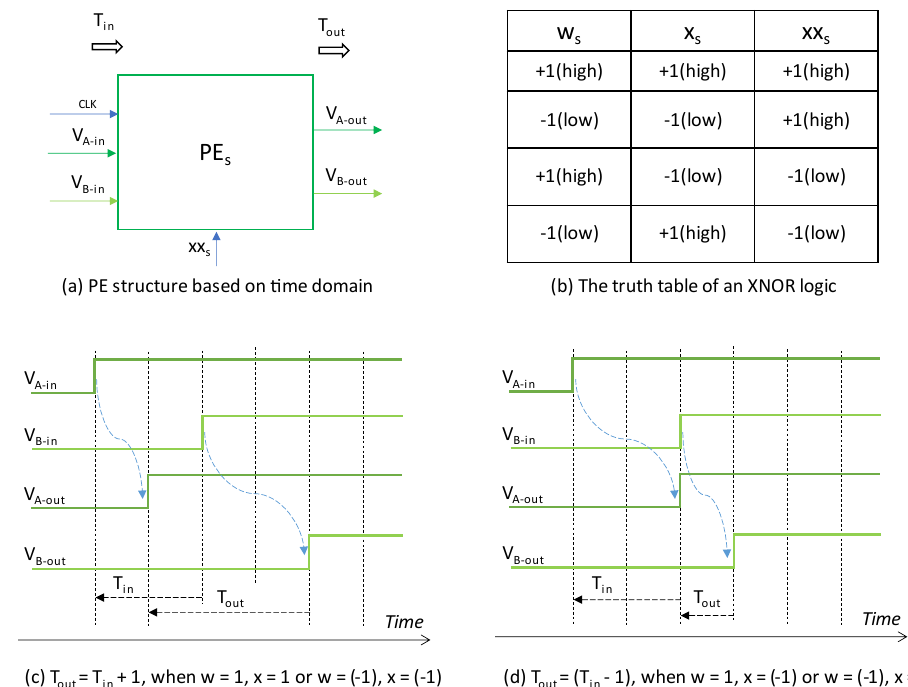
Figure 3. Time-domain PE and timing relationship.